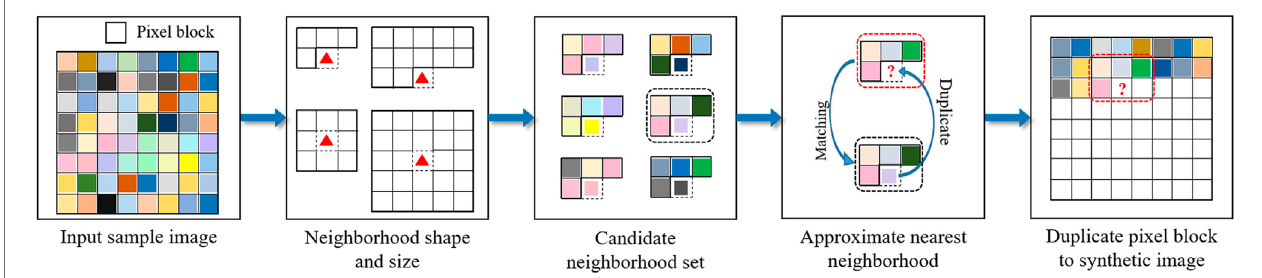
FIGURE 2 | Digital modeling method based on pixel block (revised from Xiao et al., 2021b).